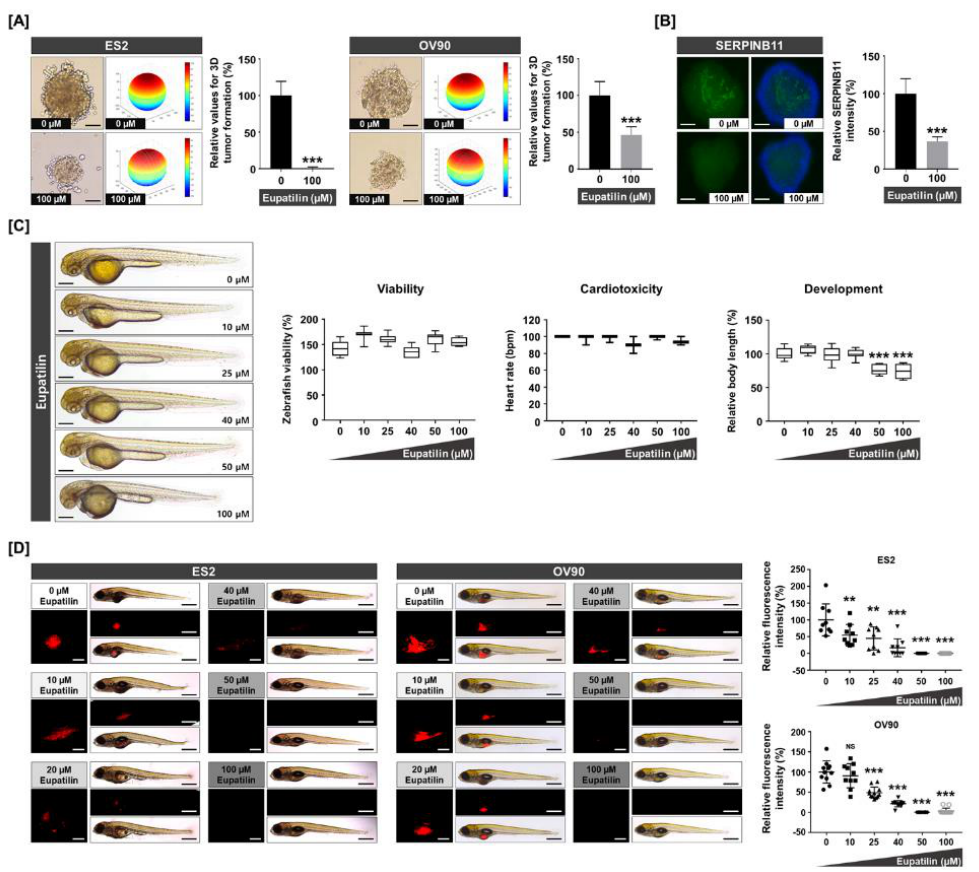
Figure 7. Anticancer e ff ects of eupatilin on in vitro and in vivo 3D anchorage-independent growth and xenograft models. ( A ) The 3D tumor spheroid-forming capacity shows that eupatilin exhibits anticancer potential under anchorage-independent cell growth conditions. The scale bar indicates 20 µ m. ( B ) Immunofluorescence of SERPINB11-positive cells (green), which were counterstained with DAPI (blue) on the ES2 tumor spheroid. The scale bar indicates 20 µ m. ( C ) Zebrafish embryos of 24 hpf were treated with increasing concentrations of eupatilin for 24 h to analyze morphology, viability, cardiotoxicity, and development as toxicological parameters. The scale bar indicates 250 µ m. ( D ) In vivo assay of anticancer e ff ects by eupatilin in a zebrafish xenograft model. Red fluorescence intensities were quantified to determine tumor formation. The scale bar indicates 25 µ m in square panels and 100 µ m in rectangle panels. The experiments were performed in triplicate. Data represent the mean ± standard deviation, and asterisks indicate that the e ff ect of treatment was statistically significant (** p < 0.01 and *** p <